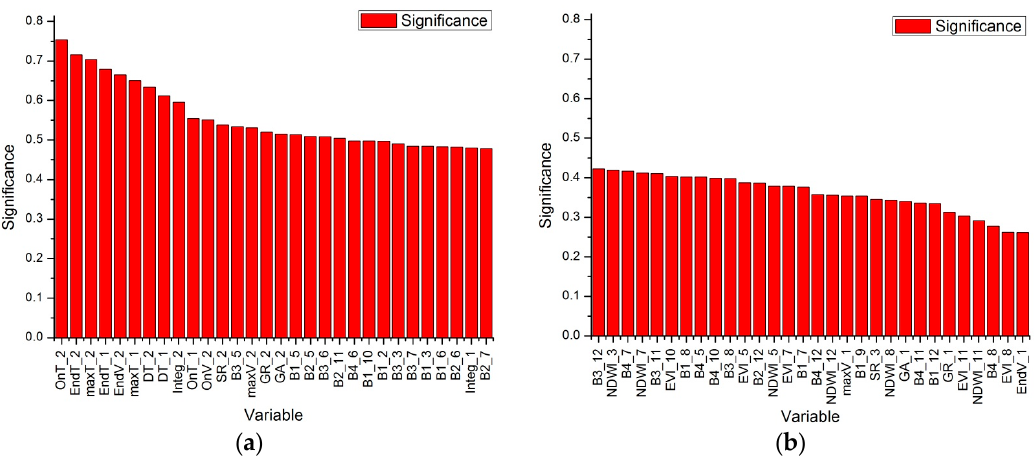
Figure 16. ( a ) The top 30 significant features; ( b ) The last 30 significant features.